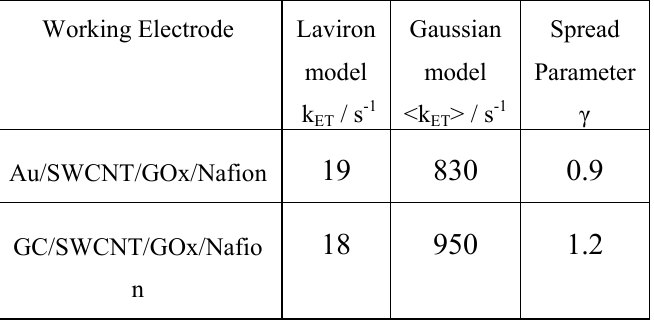
Table 3. Analysis of the FAD/FADH